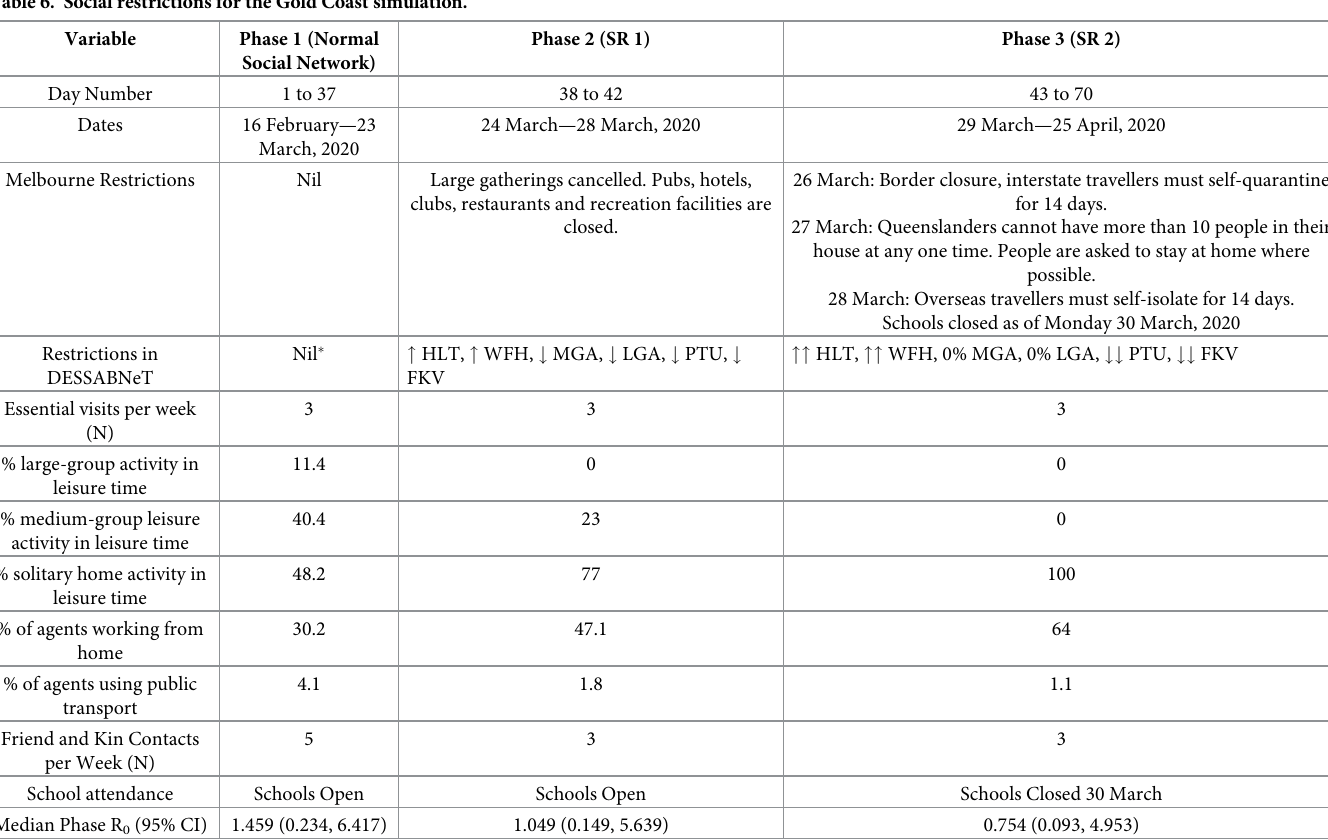
Table 6. Social restrictions for the Gold Coast